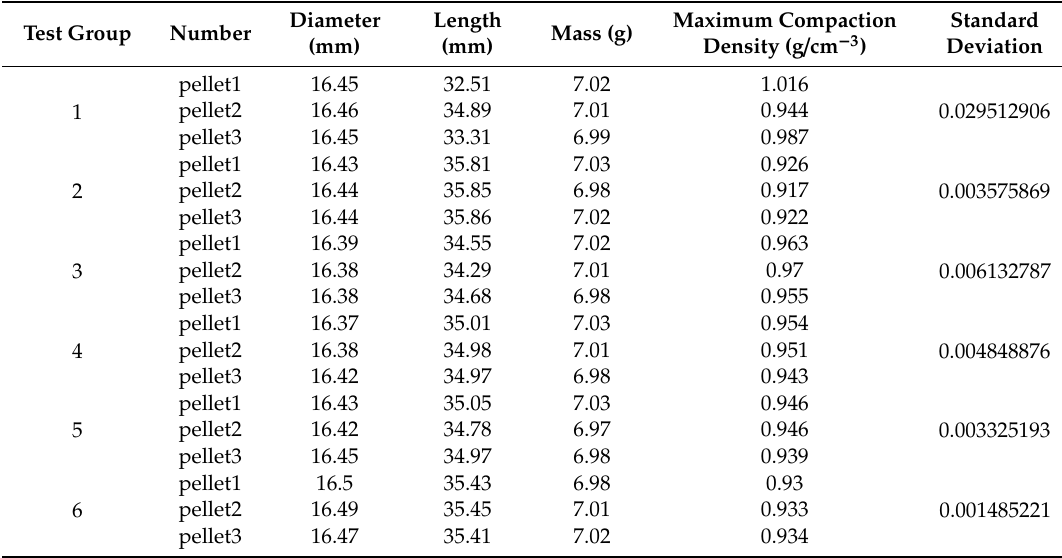
Table A1. Raw data of the